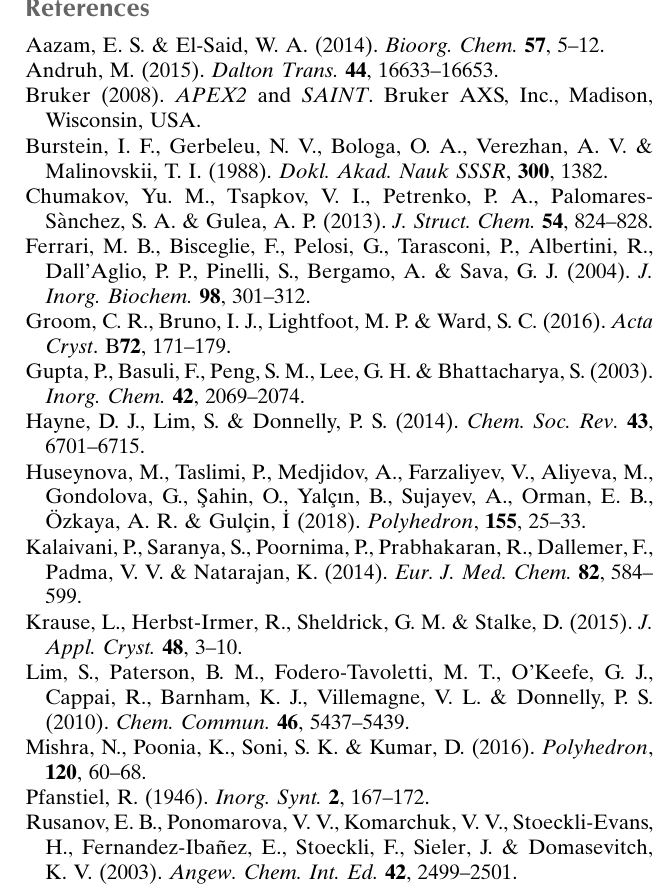
Table 2 Experimental details. Crystal data Chemical formula Crystal system, space